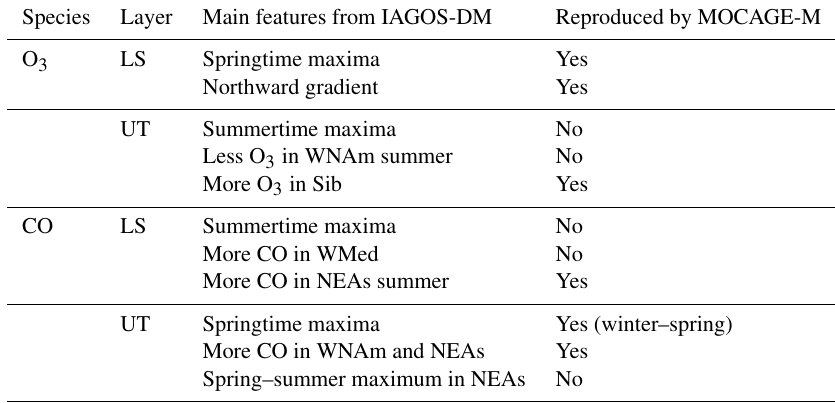
Table 5. Synthesis of MOCAGE-M ability to reproduce the main features from IAGOS-DM. Species Layer Main features from IAGOS-DM Reproduced by MOCAGE-M O 3 LS Springtime maxima Yes Northward gradient Yes UT Summertime maxima No Less O 3 in WNAm summer No More O 3 in Sib Yes CO LS Summertime maxima No More CO in WMed No More CO in NEAs summer Yes UT Springtime maxima Yes (winter–spring) More CO in WNAm and NEAs Yes Spring–summer maximum in NEAs